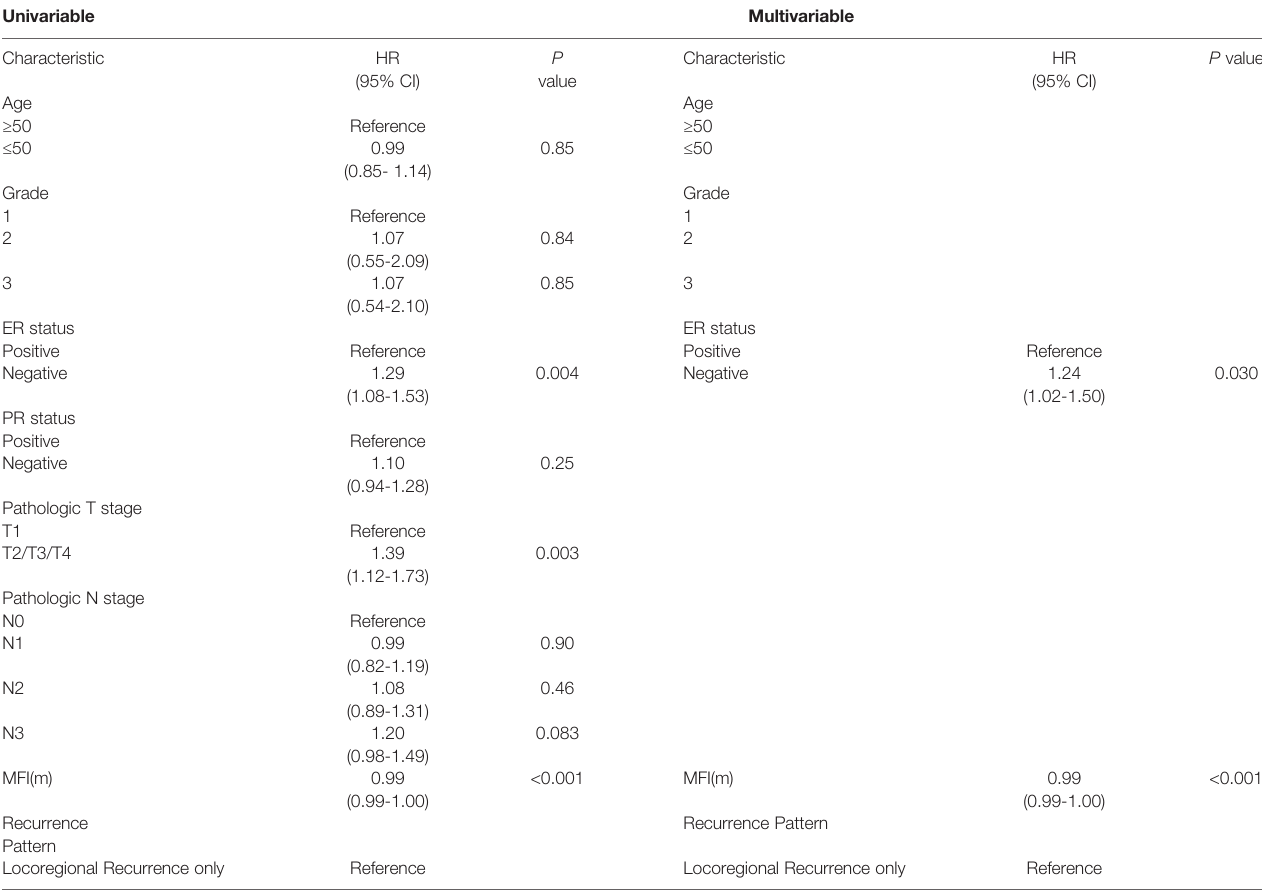
TABLE 2 | Univariable and Multivariable cox regression analyses of overall survival in the training cohort. Univariable Multivariable